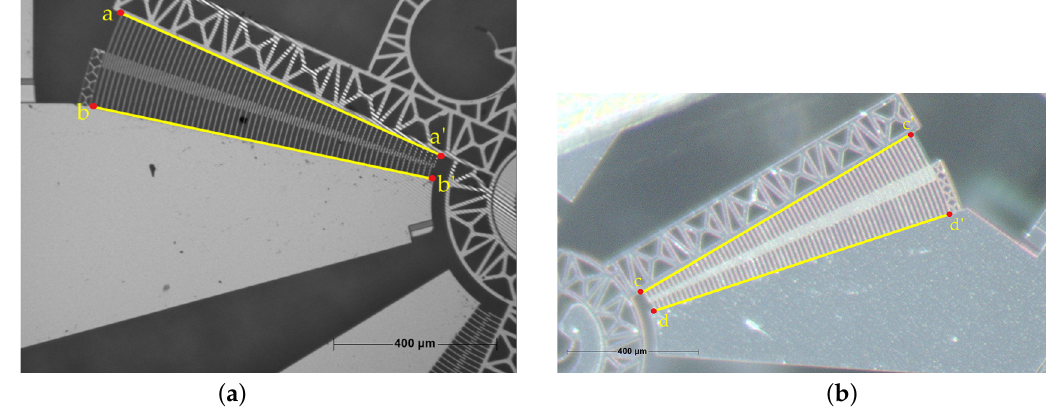
Figure 6. Two images of the microgripper comb-drive acquired by optical profilometer ( a ) and microscope ( b ),